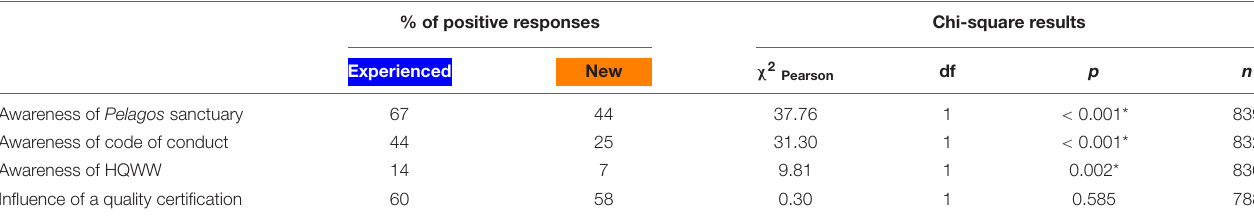
TABLE 1 | Awareness of the existence of Pelagos Sanctuary, Code of Good conduct for approaching cetaceans, HQWW R (cid:13) , and influence of the presence of a label in the choice of operator, for Experienced (blue) and New (orange) whale watchers. % of positive responses Chi-square results Experienced New χ 2 Pearson